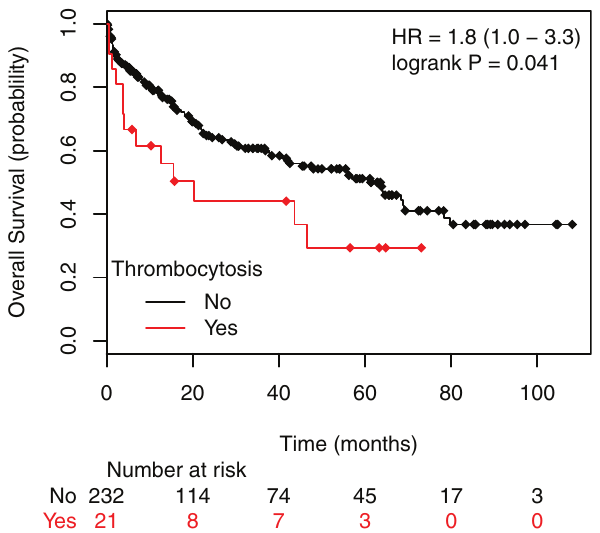
Figure 1. Mean platelet count according to the depth of tumor invasion. The mean platelet count of patients with pT1, (216 ± 71) × 10 3 /µL is significantly lower than patients with pT4 (291 ± 104) × 10 3 /µL, P =